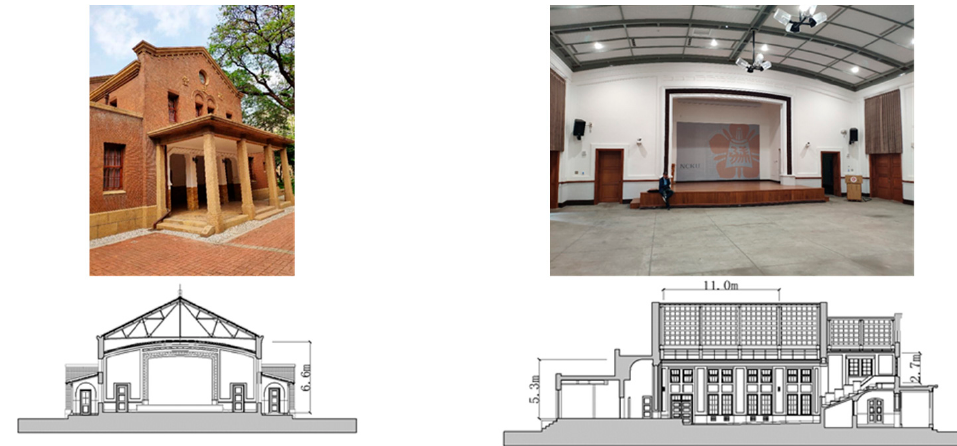
Figure 11. Ge-Chi Hall environment and section diagram.